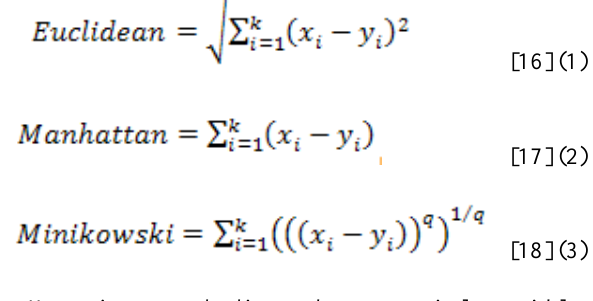
algorithm (CART), the Random Forest tree algorithm (RFT) and RFT with the K-Means learning algorithm were applied for classifying the data into the normal and cancerous cervix. The study reveals that the proposed hybrid algorithm RFT with k- means outperformed among CART and RFT with the accuracy of 96.77% on NCBI biopsy data for prediction of cervical